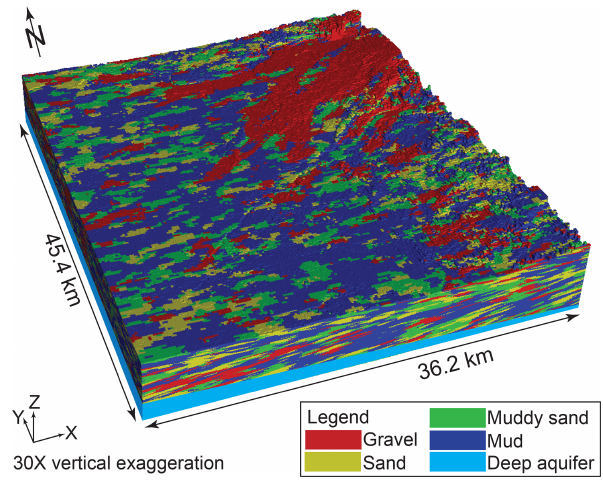
Figure 2. Three-dimensional representation of the model domain (Meirovitz, 2010; Liu, 2014).